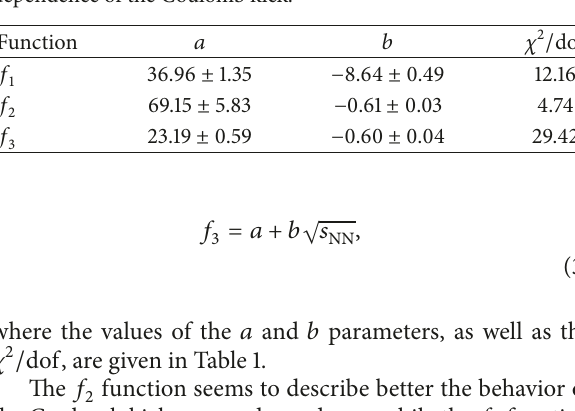
Figure 7: The Coulomb kick as a function of beam energy. The dashed and solid lines are the fits with three functions described in the text. Table 1: The parameters of the functions used to describe the energy dependence of the Coulomb